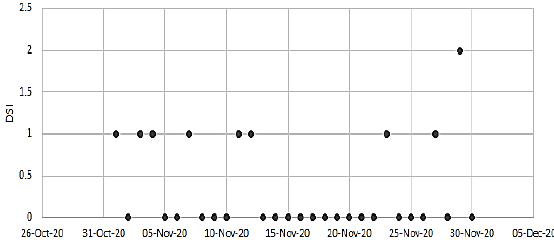
Figure 9. Dust Storm Index from 11/01 to 11/30, 2020 in Taguig City.